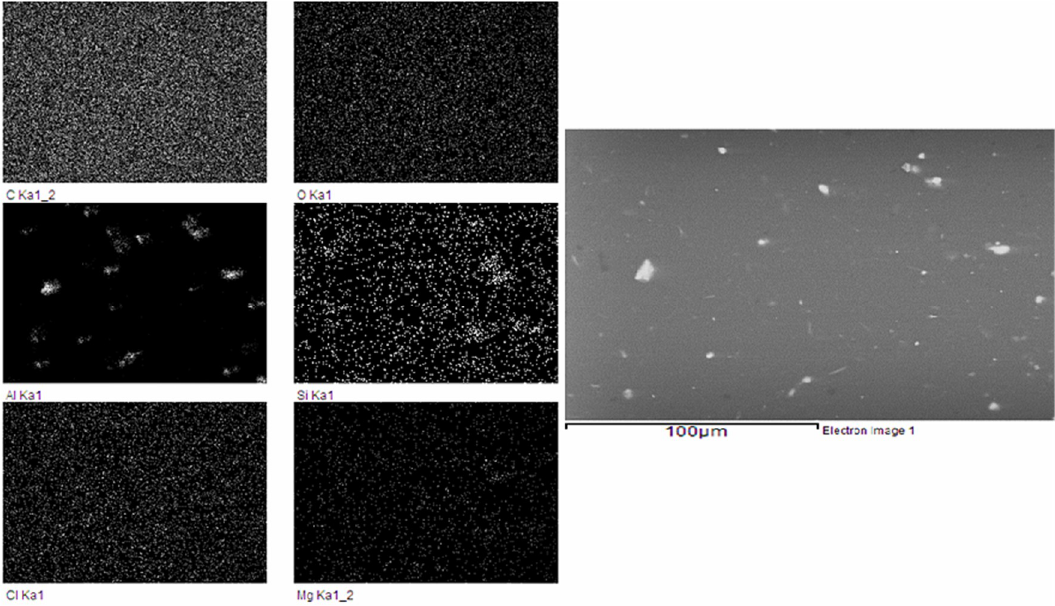
Figure 4. Mapping and sample composition for a 100 μm microstructure.